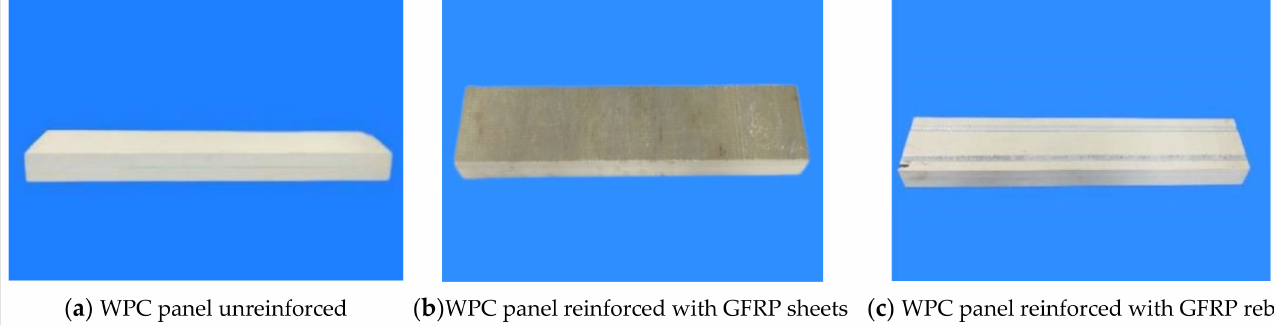
Figure 2. PVC-based WPC specimens.